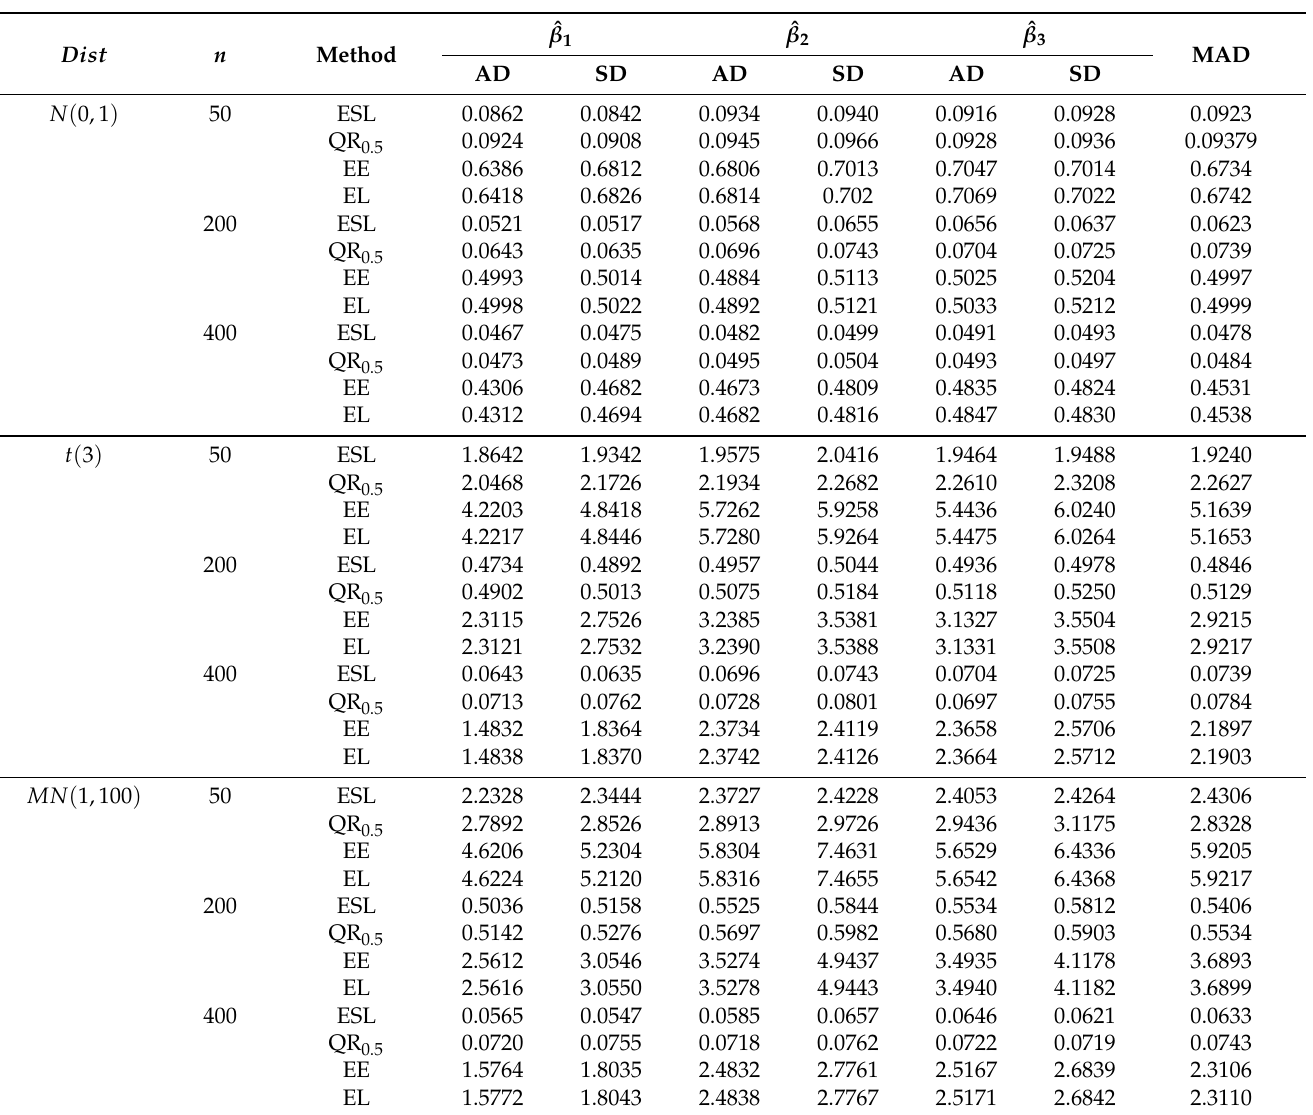
Table 1. Simulation results of AAD ( × 10 2 ), SD ( × 10 2 ), and MAD ( × 10 2 ) for the estimators of β i ( i = 1,2,3 ) .